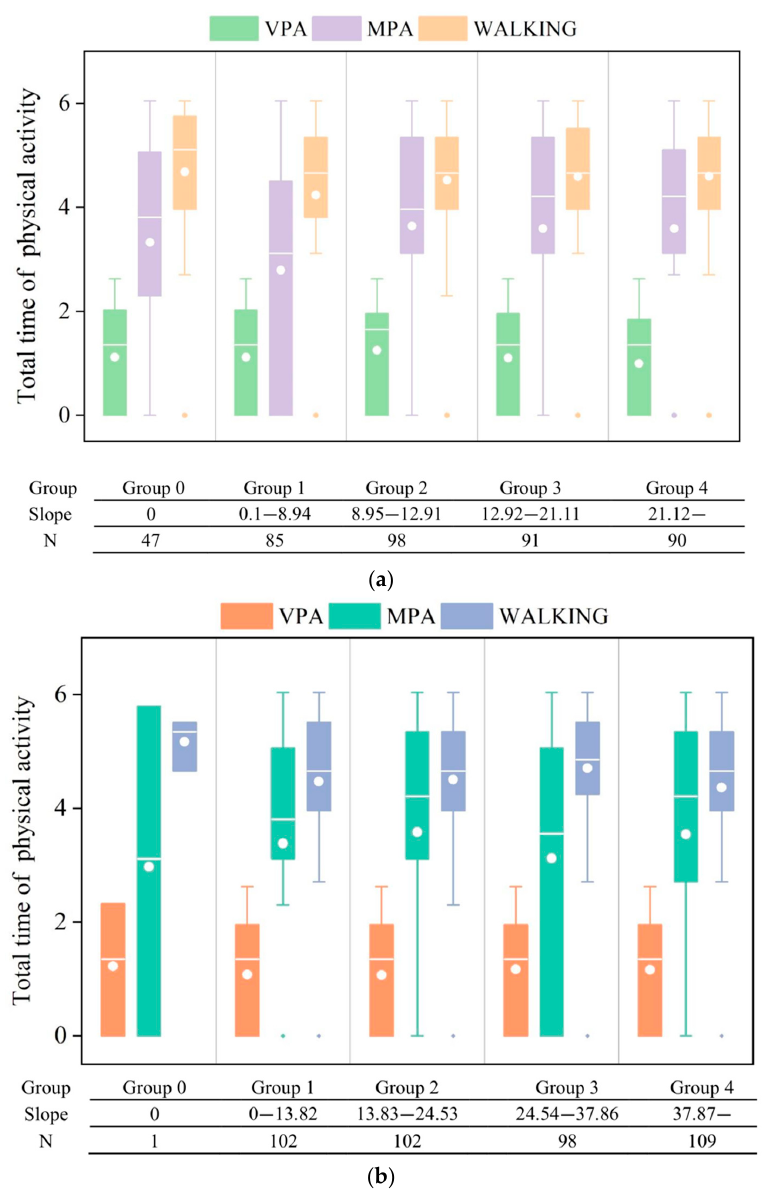
Figure 7. ( a ) Descriptive statistics grouped by slope (400 m scale). ( b ). Descriptive statistics grouped by slope (800 m scale).